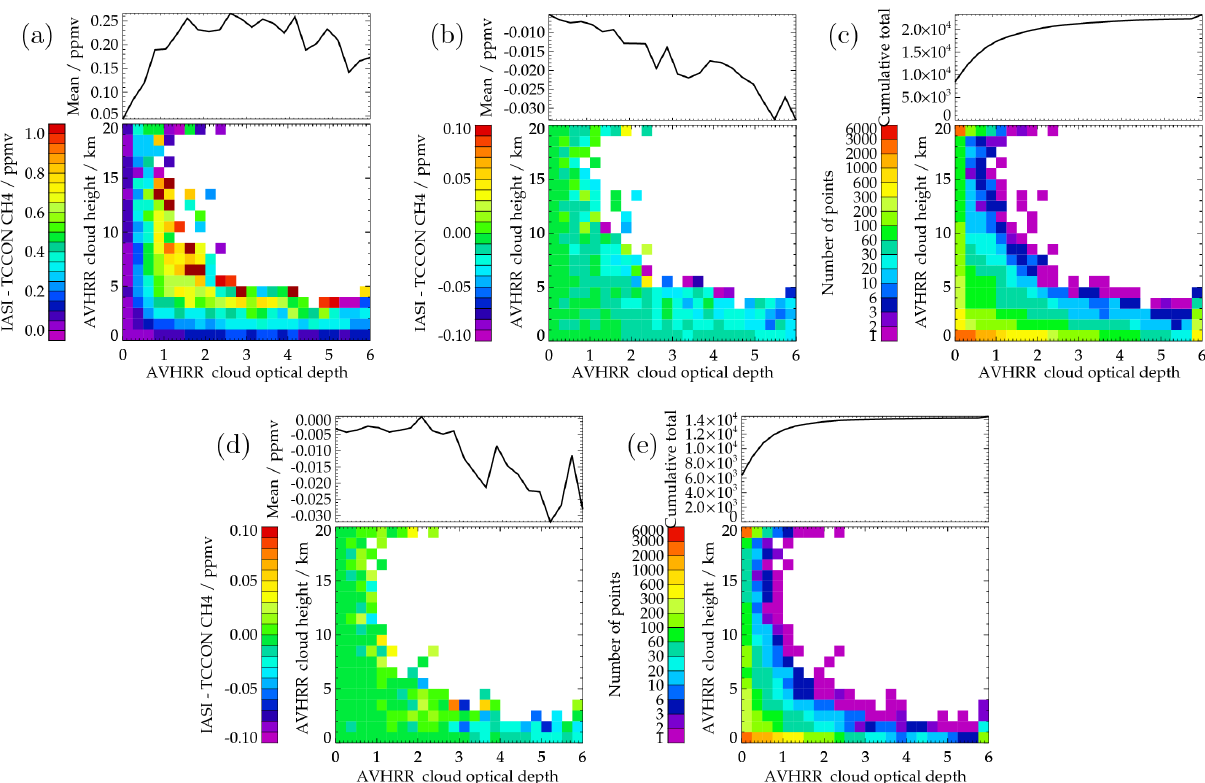
Figure 5. Panel (a) shows the mean differences between IASI and TCCON measurements (in 2009) as a function of the AVHRR cloud optical depth and height for the retrieval in which N 2 O is fitted and cloud neglected. The line plot above shows the mean difference over all cloud heights, as a function of optical depth. Panel (b) shows the same but for the new scheme with N 2 O defined and cloud parameters retrieved (note the change in ranges shown). Panel (c) shows the number of IASI retrievals in each bin, with the sub-panel above showing the cumulative total number of points as a function of increasing optical depth. Panels (d) and (e) are the same as panels (b) and (c) , respectively, after removing scenes with retrieved cloud fraction larger than